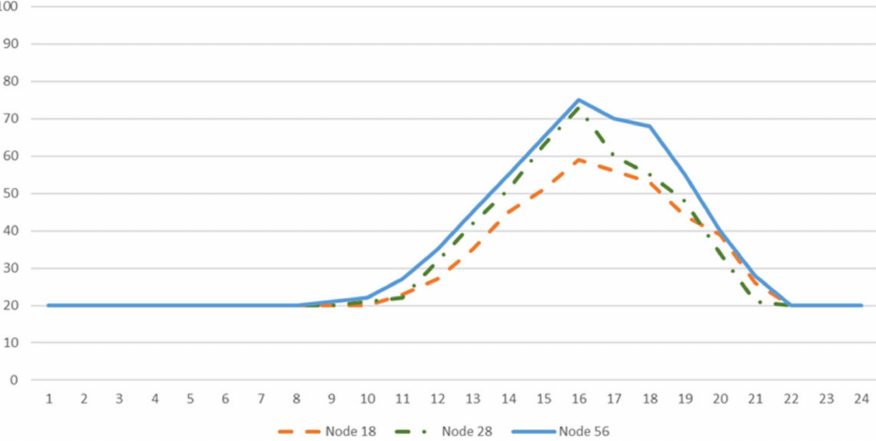
Figure 3. 24 h SOC (%) of three of the energy storage devices of the microgrid, allocated at node 18 (orange); node 28 (green); node 56